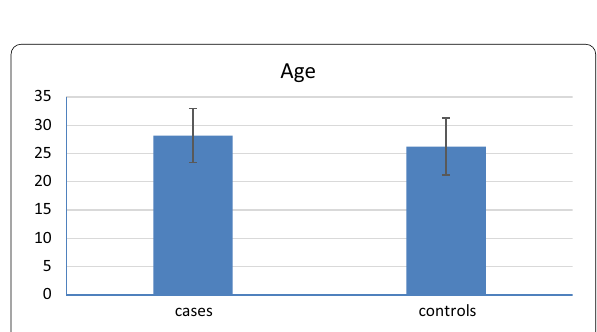
Fig. 2 Age in patients and control groups